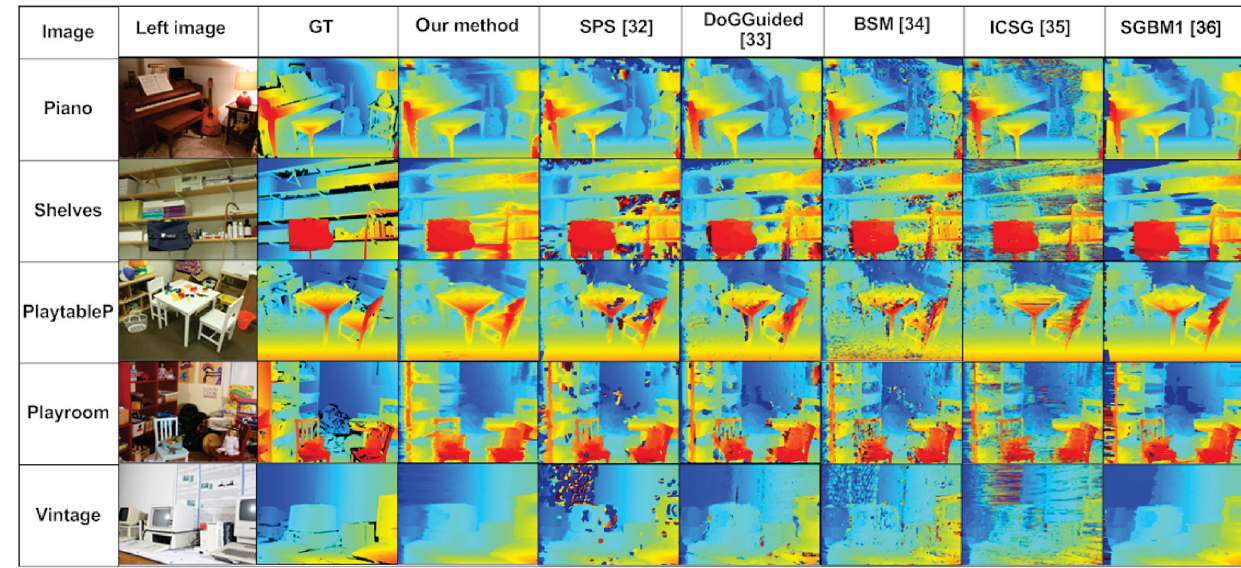
Fig. 3 Disparity maps for the proposed algorithm and other methods on